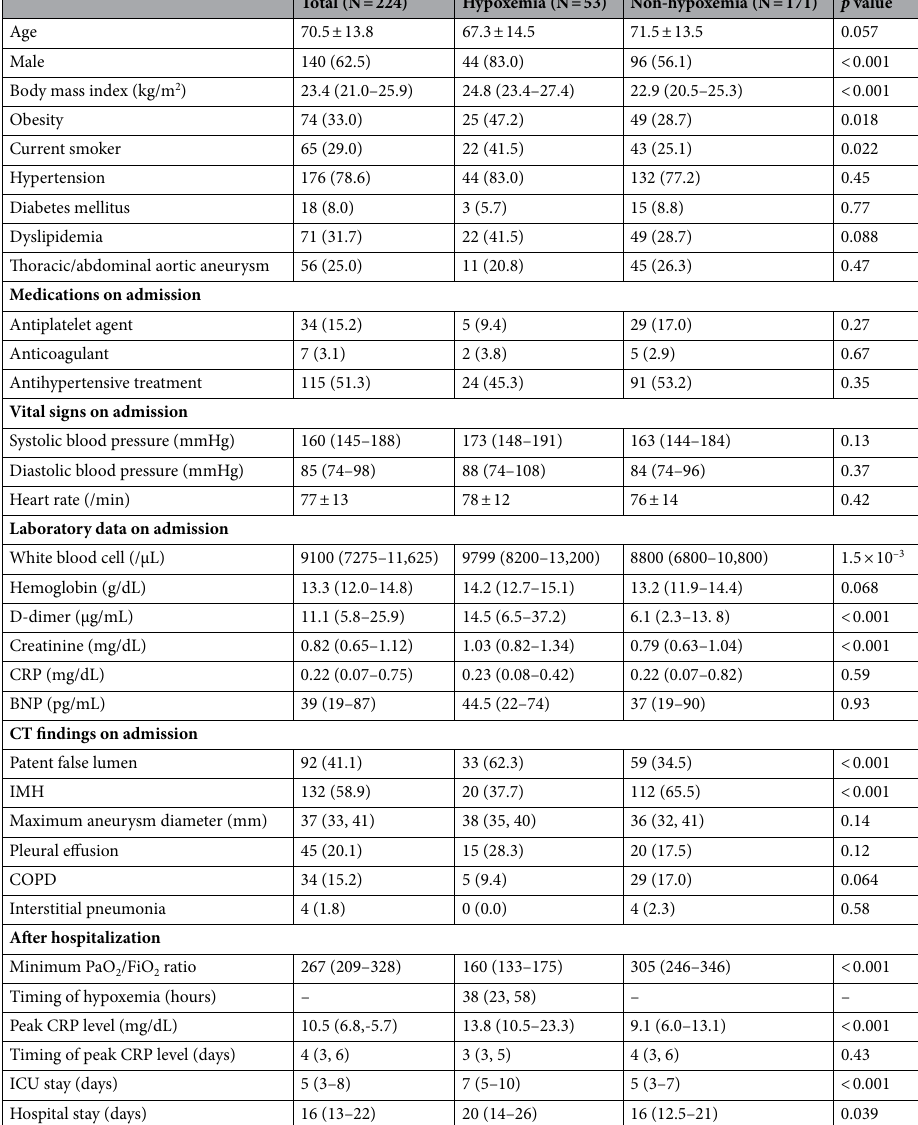
Table 1. Baseline characteristics of study participants with type-B acute aortic syndrome. Values are mean ± standard deviation, median (interquartile range), or n (%). CRP C reactive protein, BNP brain natriuretic peptide, CT computed tomography, IMH intramural hematoma, COPD chronic obstructive pulmonary disease, ICU intensive care